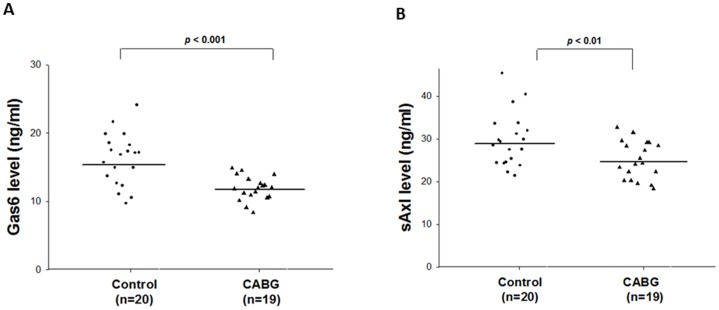
Plasma growth arrest-specific protein 6 (Gas6) and soluble Axl (sAxl) levels in control subjects (Control) and patients undergoing coronary artery bypass grafting (CABG).The lines represent the mean values in each group. The CABG group had significantly lower plasma Gas6 and sAxl levels than the control subject group (P<0.0001 and P<0.001, respectively).